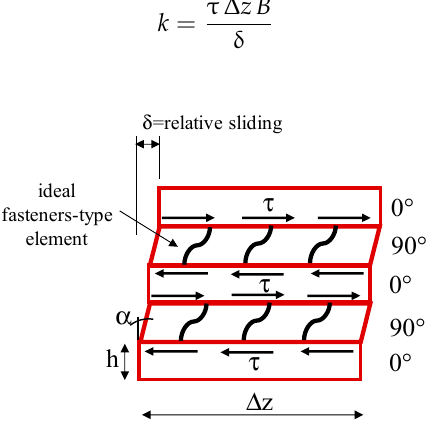
Figure 4. Schematization of CLT transverse layers into ideal fasteners-type elements.